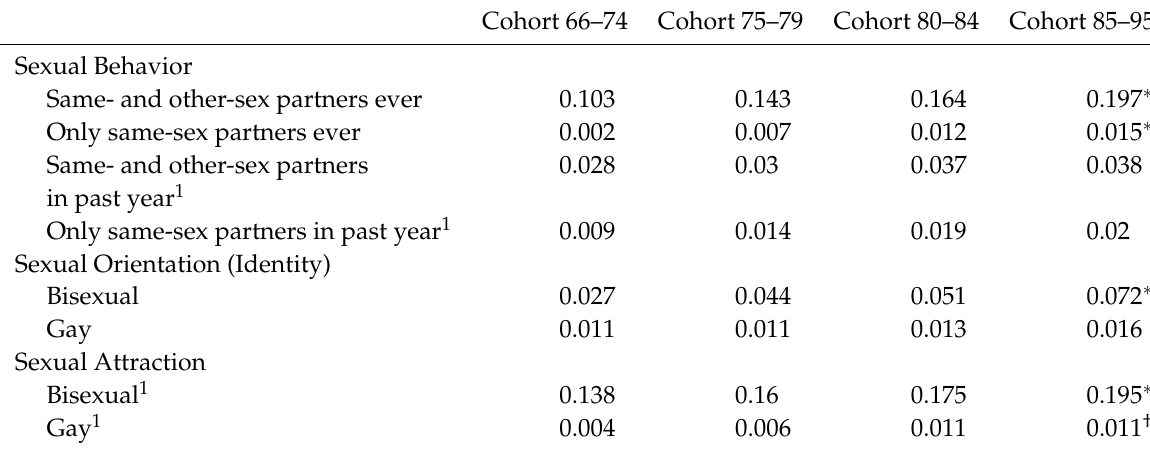
Table 3: Women’s predicted